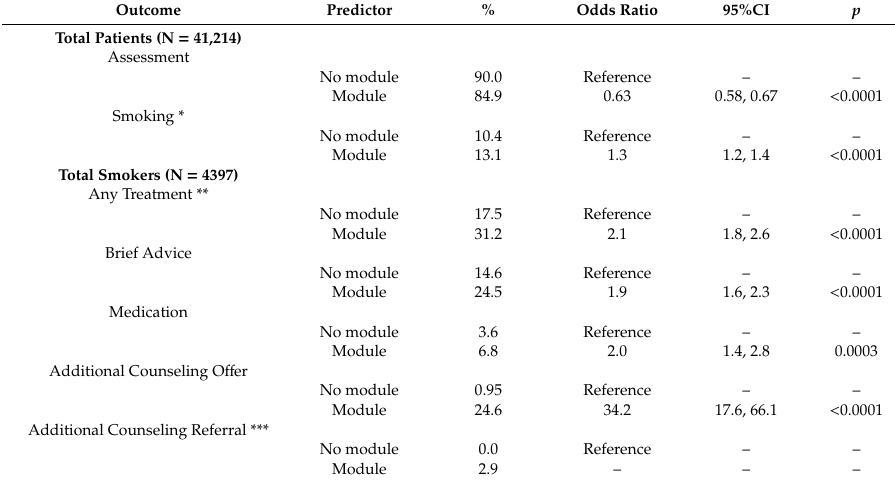
Table 6. Results of generalized estimating equations analyses predicting smoking prevalence and treatment engagement among patients in cancer clinics that used the module and cancer clinics that did not use the module adjusting for the clustering of patients within